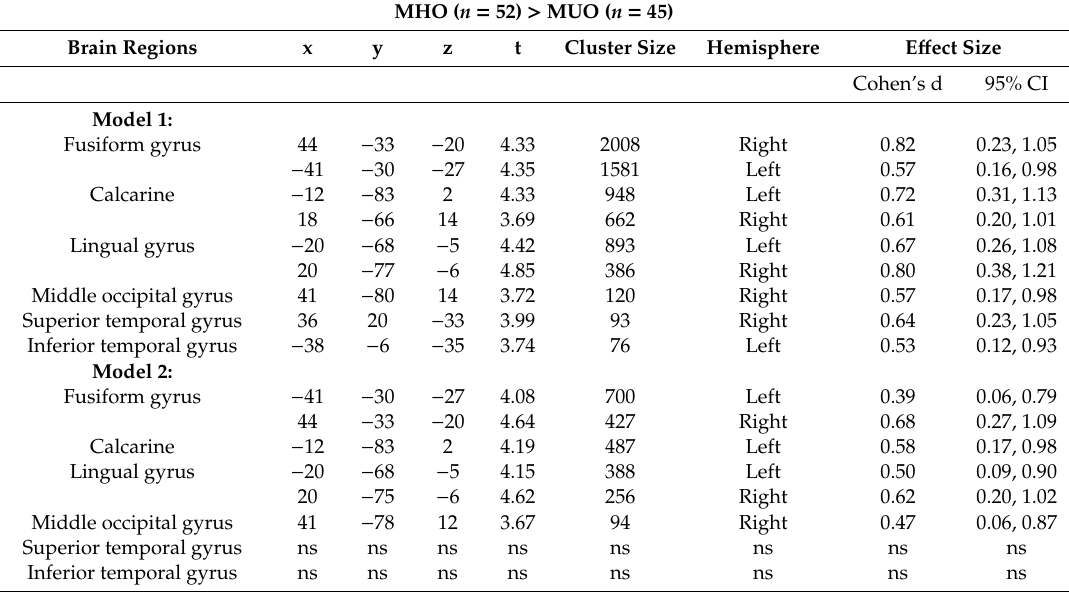
Table 2. Brain regions showing gray matter volume increases in metabolically healthy overweight / obesity compared to metabolically unhealthy overweight / obesity ( n = 97). MHO ( n = 52) > MUO ( n =